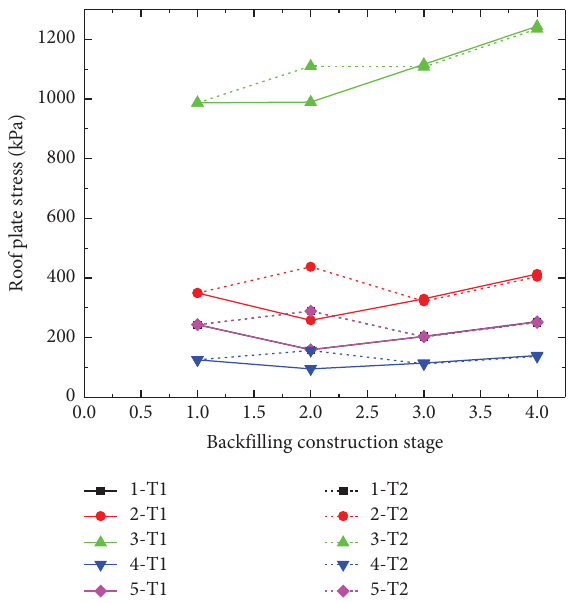
Figure 21: Stress of the roof in the middle-to-side backflling